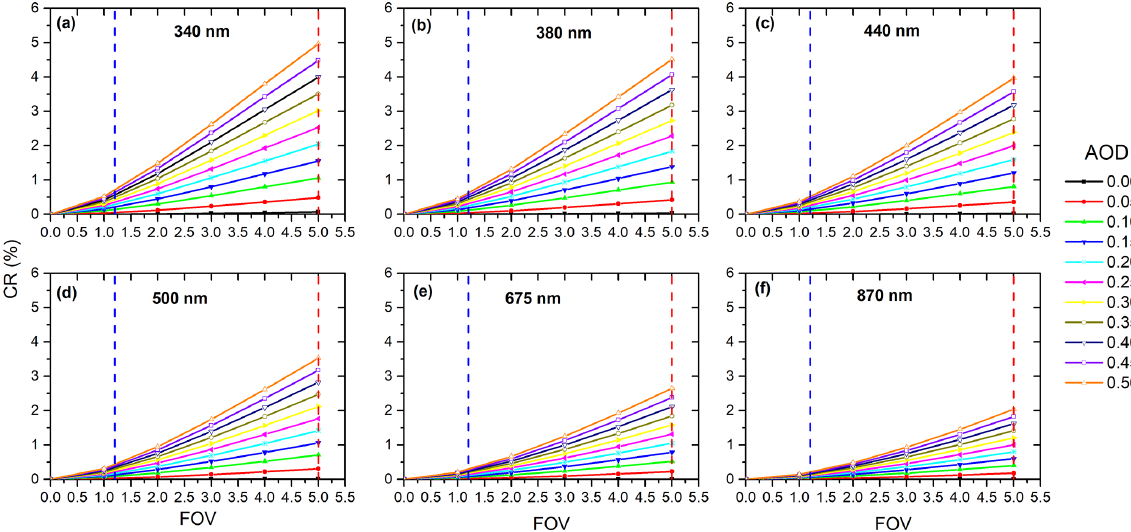
Figure 5. Simulations of CR at (a) 340, (b) 380, (c) 440, (d) 500, (e) 675, and (f) 870nm for AOD between 0.0 and 0.50, and FOV between 0 and 5 ◦ at SZA 30 ◦ . The dashed blue and red lines represent the Cimel FOV (1.2 ◦ ) and EKO MS-711 FOV (5 ◦ ) respectively.